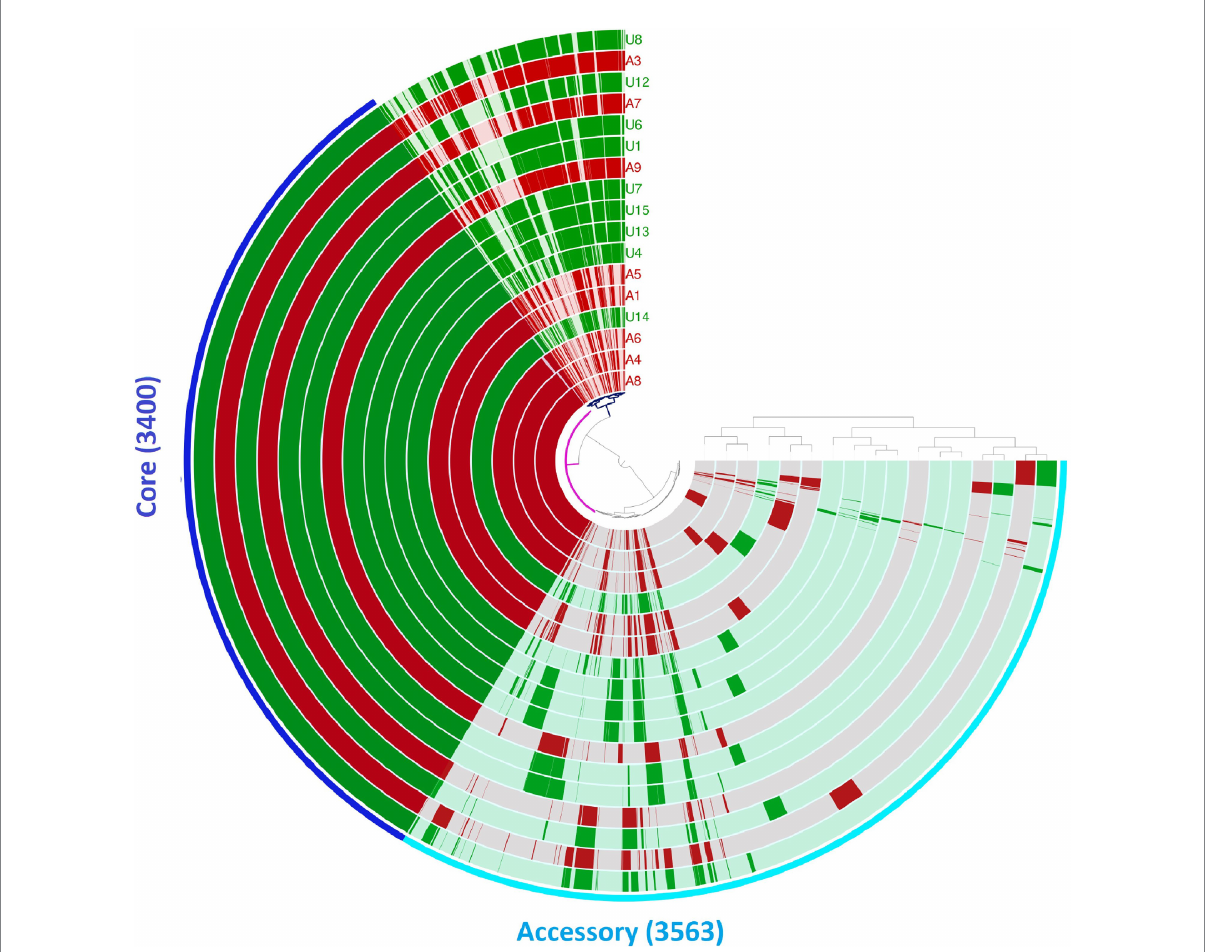
FIGURE 2 Pan-genome analysis of 17 NLF E. coli genomes from Anvi’o pan-genomics suite. The circles represent individual genomes arranged as per their pan-genomic phylogenetic relationship depicted by the outside dendrogram. In the circles, dark colour indicates the presence of a gene group and light colour its